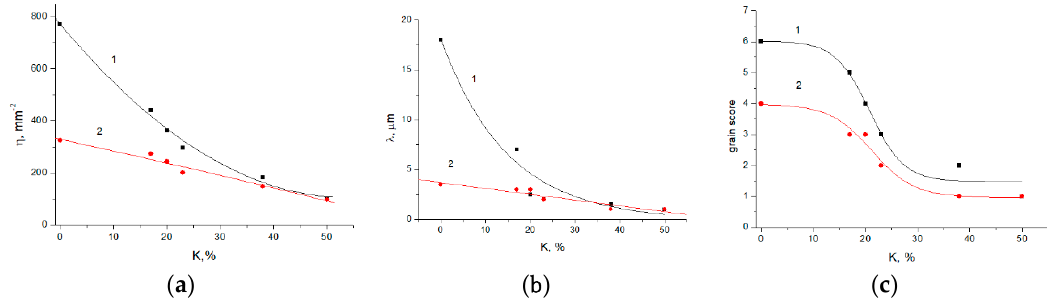
Figure 7. Changes in pore density ( a ), maximum pore size ( b ), and grain score ( c ) depending on the degree of reduction in radial forging: 1—center of the workpiece; 2—surface layer.